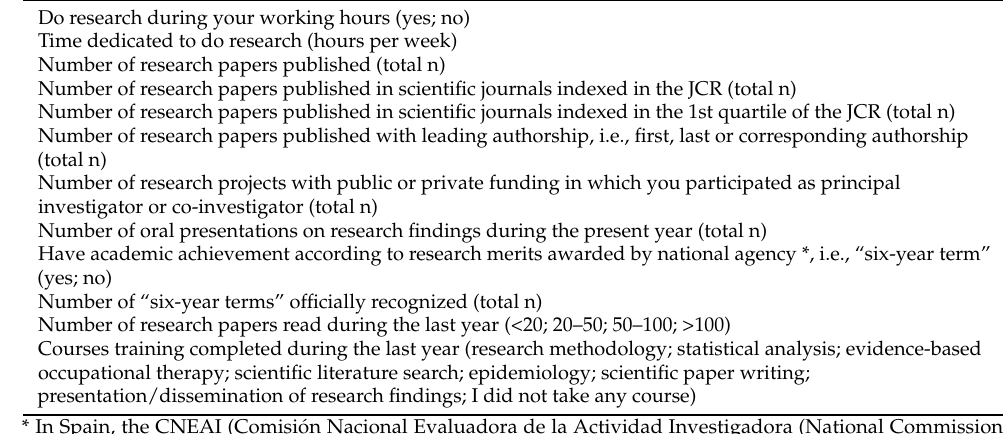
Table 2. Summary of the data on research or academic experience collected in the HACTO-Screen